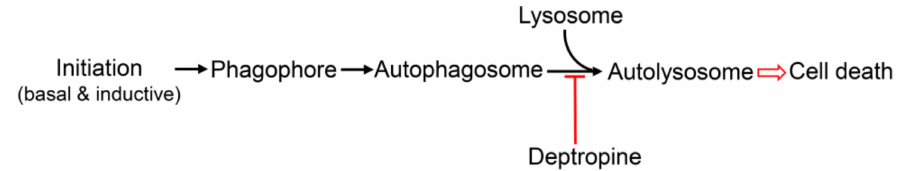
Figure 8. The possible mechanisms of deptropine-induced cell death in human hepatoma